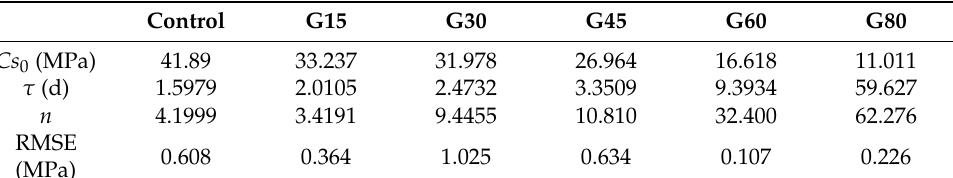
Table 5. Coefficients of Equation (1), Cs 0 , τ , and n , fitted to the measured values of the compressive strength, for each one of the studied cases (see Table 4), together with the Root Mean Squared Error (RMSE) of each fitting.